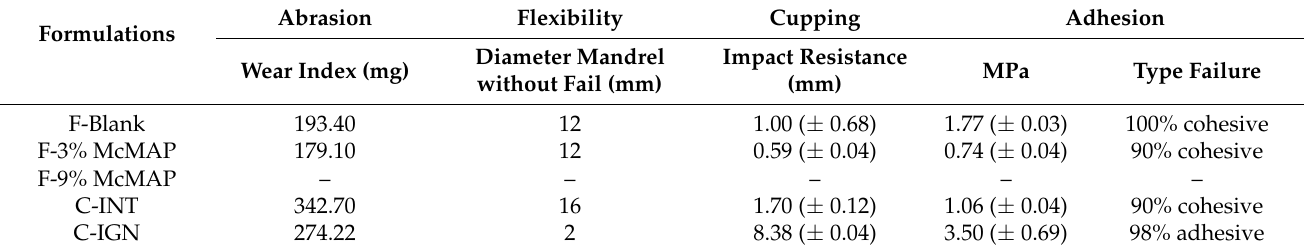
Table 6. Evaluation of the mechanical properties of